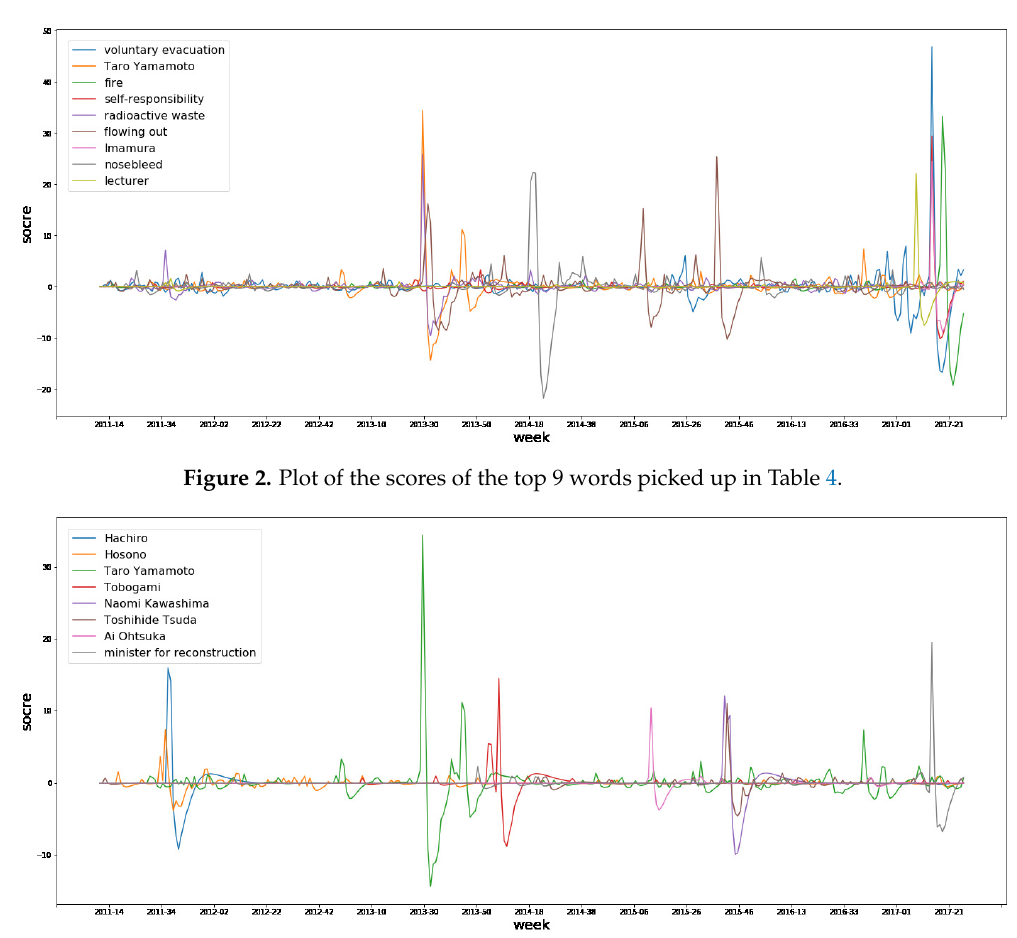
Figure 3. Plot of the scores of some key-persons that appear in Tables 2 and